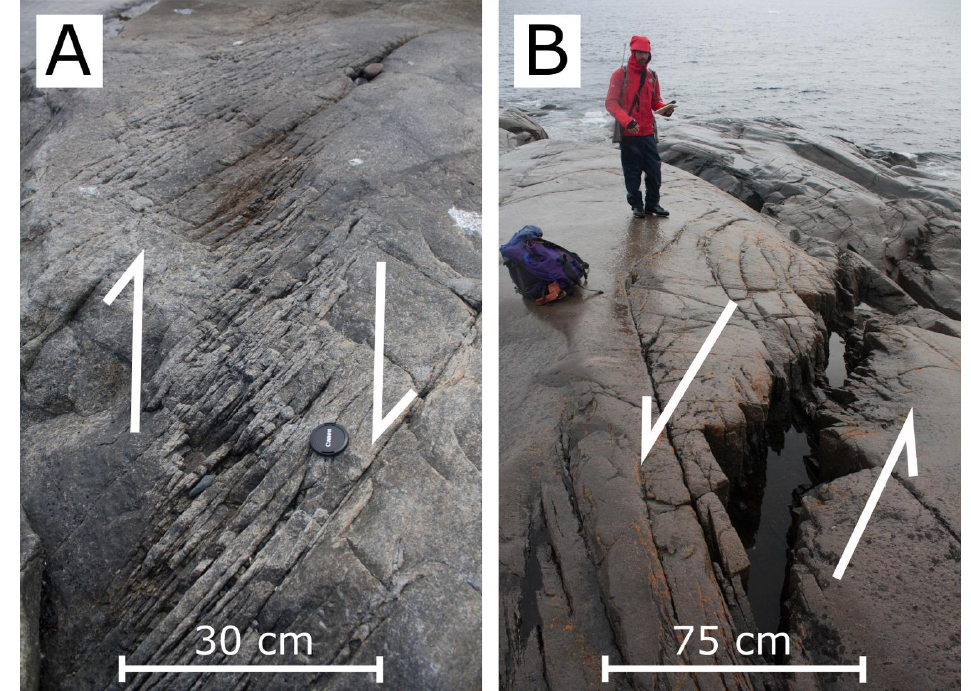
Figure 7. Examples of the abundant fracture zones in the basement that potentially indicate shear deformation on ( A ) the north coast of Big Island and ( B ) the coastline north of Ikey’s point (Figure 3).